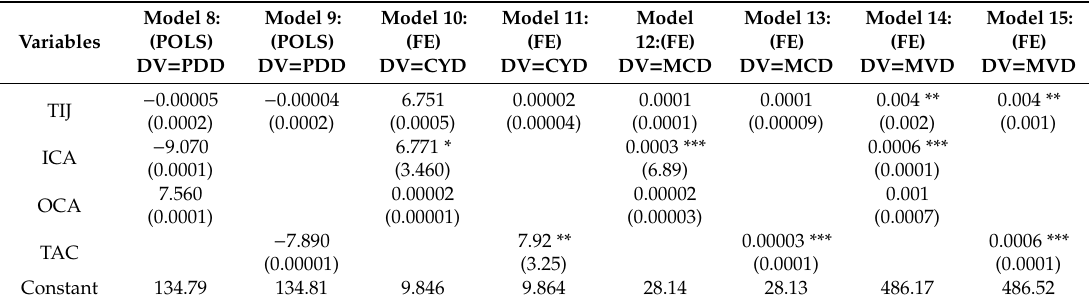
Table 4. Regression analysis for the prediction of pedestrian death, cyclist death, motorcyclists death, and motor vehicle death by total injuries, inside-city accidents, outside-city accidents, and total number of